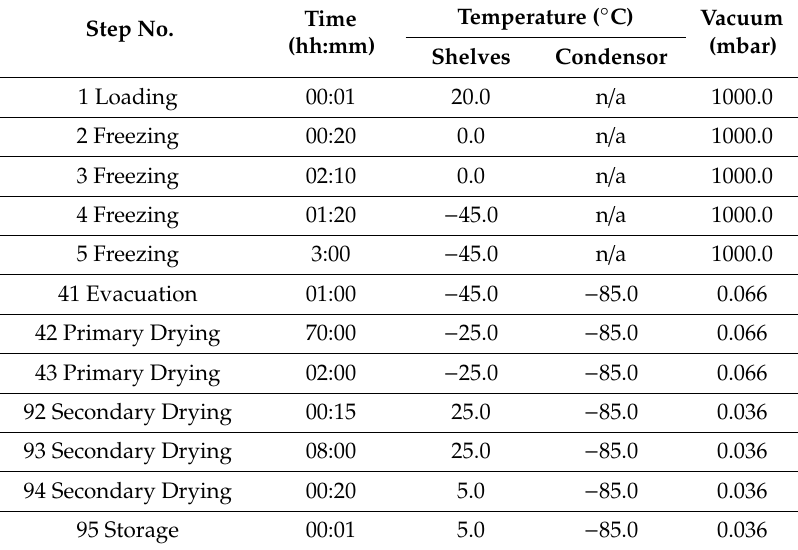
Table 1. Freeze drying cycle for temperature measurement